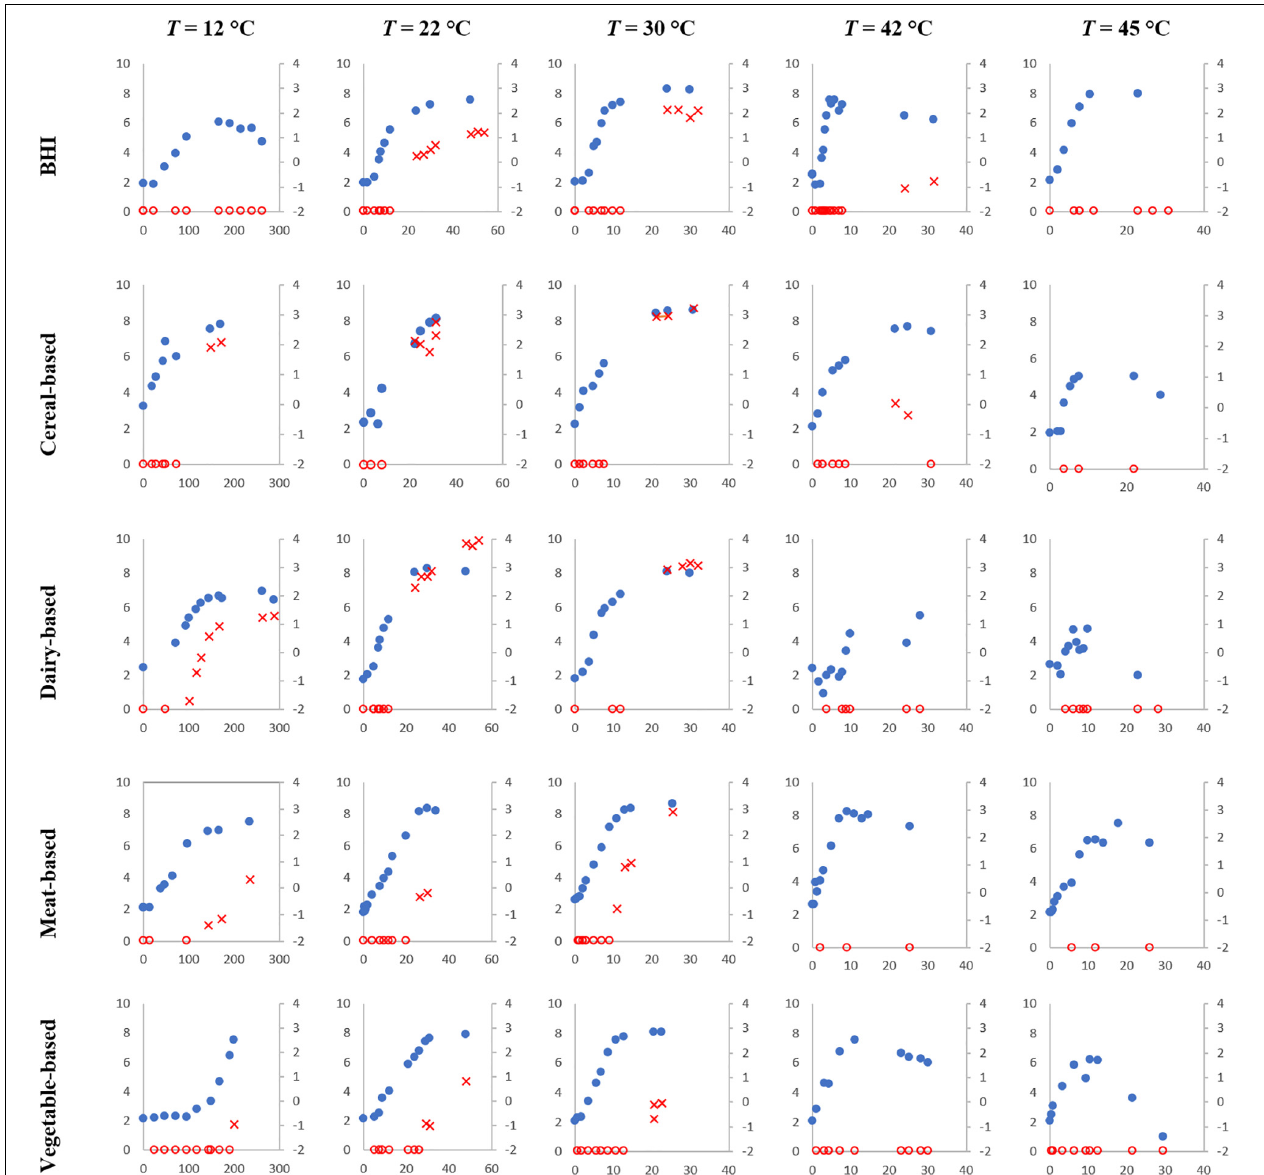
FIGURE 2 | Simultaneous B. cereus (strain F4810/72) growth (blue dots, primary axis) in log CFU/g or /ml and cereulide formation (empty red circles when cereulide was lower than the Limit of Quantification LoQ and red crosses when cereulide was quantified, secondary axis) in log ng/g or /ml over time (h) at 12, 22, 30, 42, and 45 ◦ C in the tested